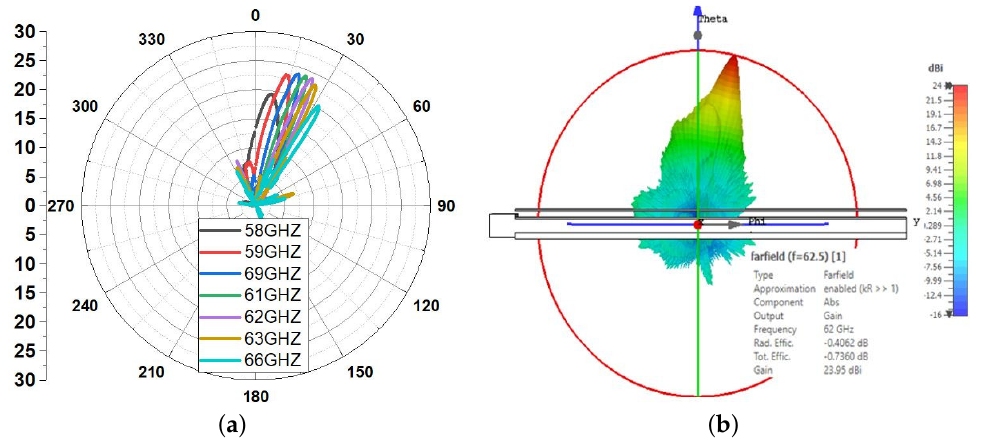
Figure 7. LWA simulation results: ( a ) 2-D FRPs in E -plane at various frequencies within the operating band; ( b ) 3-D FRP of the proposed LWA at 62.5